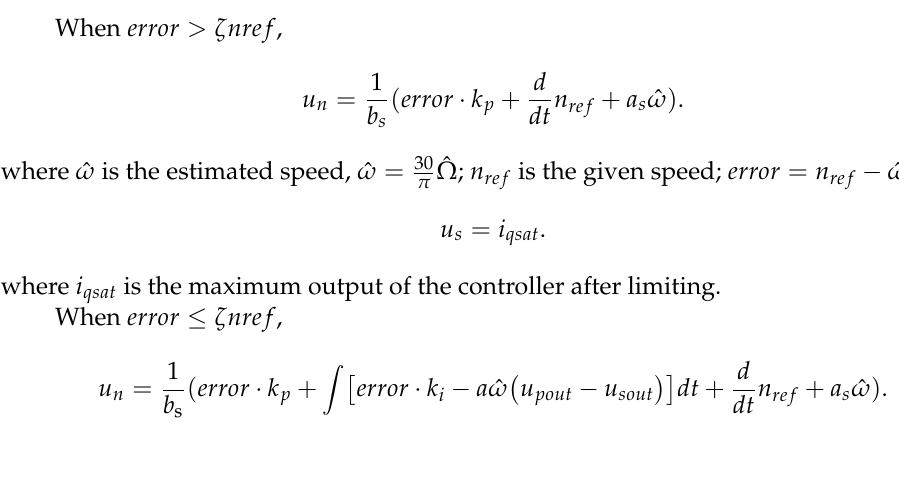
Figure 3. Block diagram of the novel CVSPI controller